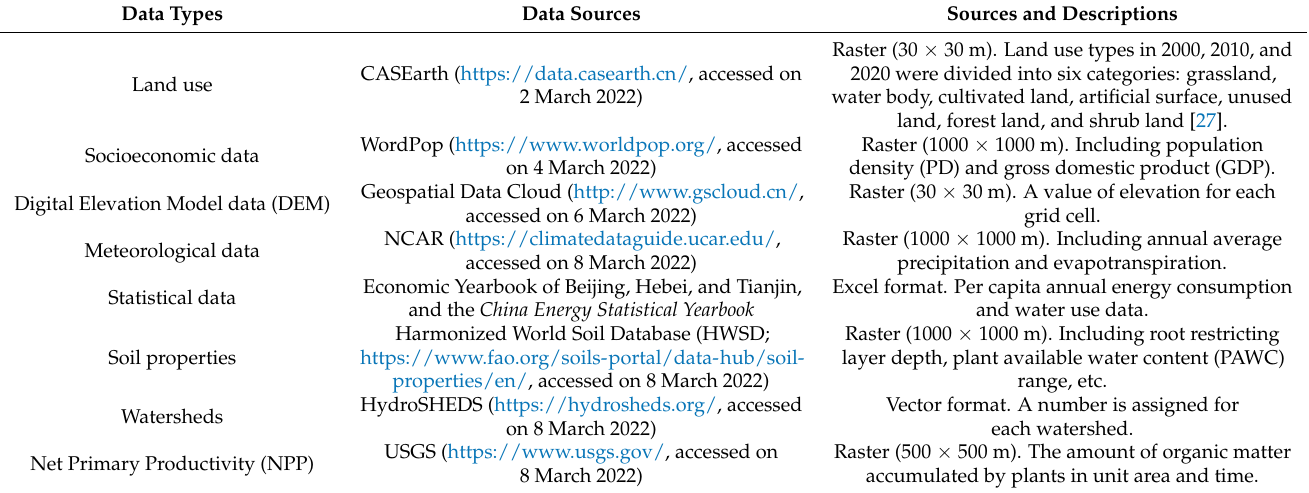
Table 1. The data requirements, sources, and descriptions.